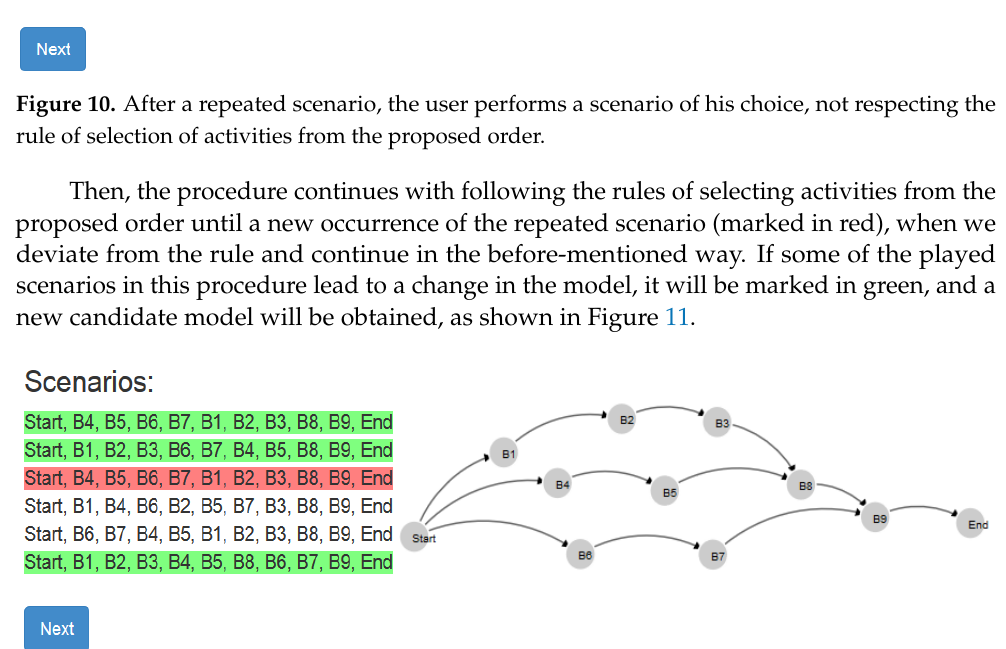
Figure 12. The final model of the observed process example. By using the described demonstration procedure, in the majority of cases examined, the first appearance of the repeated scenario means that the performance of all the follow- ing scenarios will not lead to a change in the model, that is, the last obtained candidate model is in fact the final model of the process as well, which will be discussed later. During the demonstration, after each performed scenario, all relations defined in the modified PM technique (Definition 1 [6], Definition 4 [7]) appeared on the screen (Figure 13), as well as the footprint of the event log from which the relationships were established (Figure 14), obtained on the basis of all the scenarios performed. Figure 13 shows the layout of the relationships that were obtained after two played scenarios of execution of the observed process, shown in Figure 8. In addition to the rela- tions defined by the modified PM technique, the layout showed: NO_DIRECT  - activities which do not have a direct successor, NO_DIRECT  - activities which do not have a direct predecessor, INFERRED  i , INFERRED  i - causality relations that have not been revealed on the basis of the scenarios performed, but have been subsequently concluded from the event log using Rule 1 or Rule 2, for the activities that do not have a direct successor or predecessor, respectively.